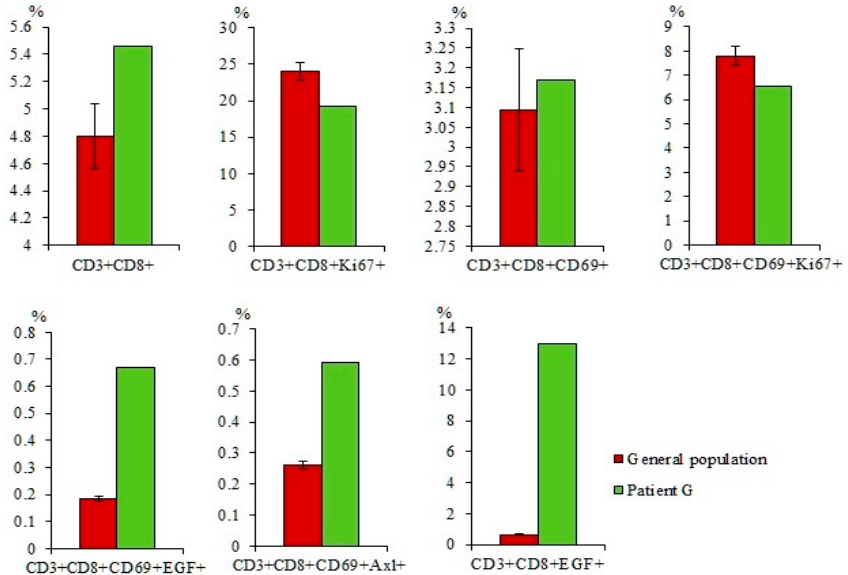
Figure 10. The content of CD3 + С D8 + , CD3 + С D8 + Ki67 + , CD3 + С D8 + CD69 + , CD3 + С D8 + CD69 + Ki67 + , CD3 + С D8 + CD69 + EGF + , CD3 + С D8 + CD69 + Axl + , and CD3 + С D8 + EGF + in the blood of the general population SCLC patients and patient G (% of all labelled mononuclear cells). Cells were analyzed by flow cytometry using antibodies against CD3, CD8, CD69, EGF, Axl, and Ki67.